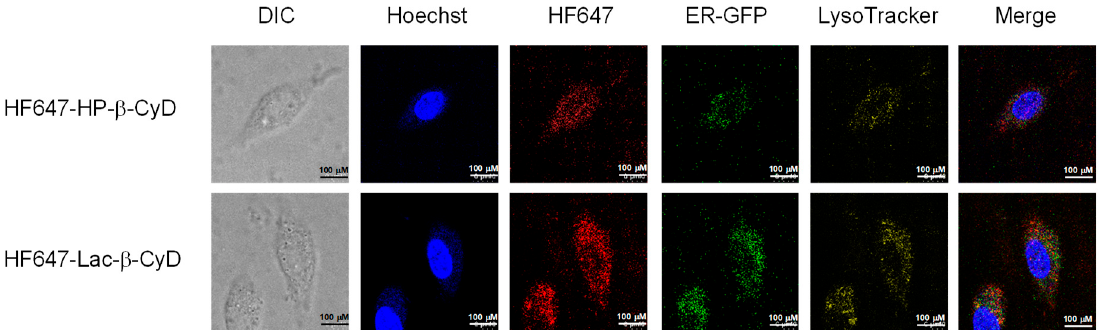
Figure 5. Intracellular distribution of HF647-Lac- β -CyD in NPC-like liver cells. U18666A-treated HepG2 cells were stained by CellLight ® ER-GFP, BacMam 2.0 for 16 h at 37 °C. After washing in PBS, the cells were exposed to culture medium containing HF647-Lac- β -CyD (0.1 mM, 24 h) or HF647-HP- β -CyD (0.1 mM, 24 h) with or without AF (1 mg / mL), and were stained using HF647-HP- β -CyD (0.1 mM, 24 h) with or without AF (1 mg/mL), and were stained using LysoTracker and Hoechst 33342, for endolysosomes and nucleus, respectively. These figures show the representative images of three experiments.